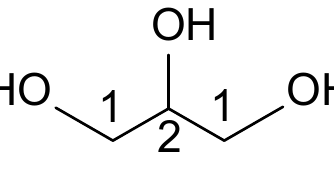
Figure 4. Nuclear magnetic resonance (NMR) spectrum of glycerol; ( A ) ¹H-NMR spectrum of the purified fraction; ( B ) ¹H-NMR spectrum of the purified fraction (enlarged); ( C ) ¹H-¹H COSY spec- trum of the purified fraction; ( D ) ¹³C-NMR spectrum of the purified fraction; ( E ) ¹H-¹³C HSQC spec- trum of the purified fraction.